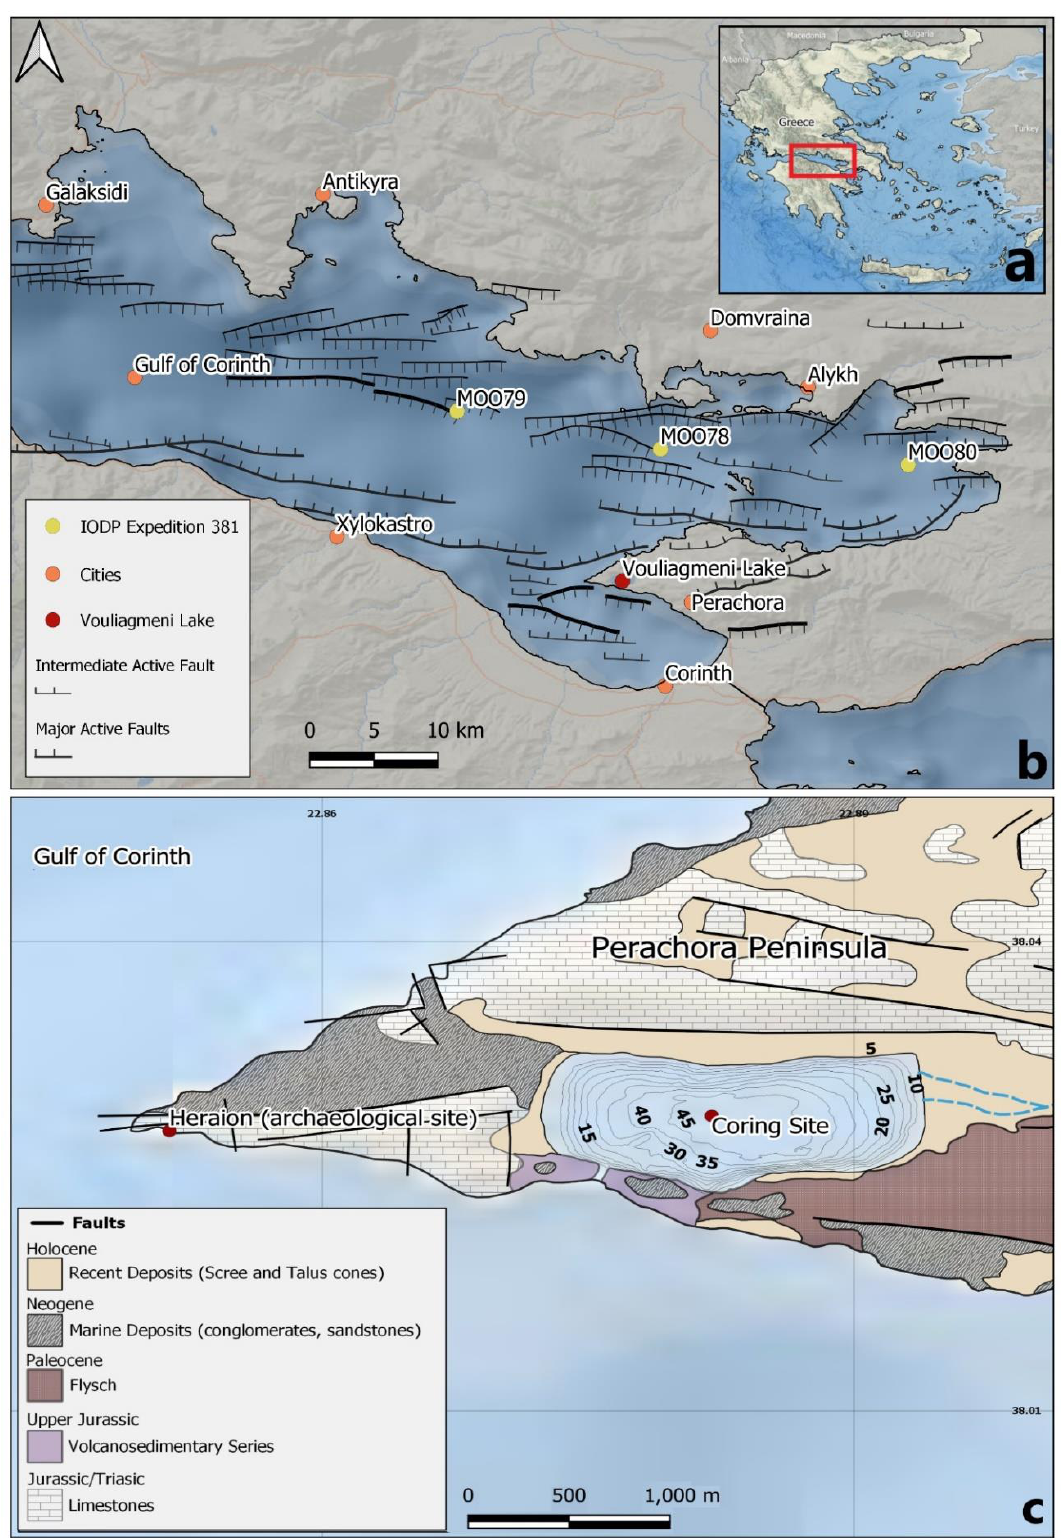
Figure 1. ( a ) Map of Greece with the study area highlighted. ( b ) Map of the eastern part of the Gulf of Corinth, presenting the major fault systems (modified from [78]), cities, IODP expedition 381, and the study area. ( c ) Simplified geological map of the study area based on geological mapping from Hellenic Survey of Geology and Mineral Exploration.